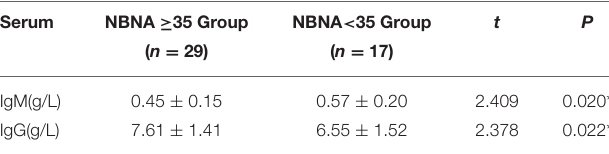
TABLE 5 | Comparison of serum immunoglobulin levels in newborns with HFMD and encephalitis.